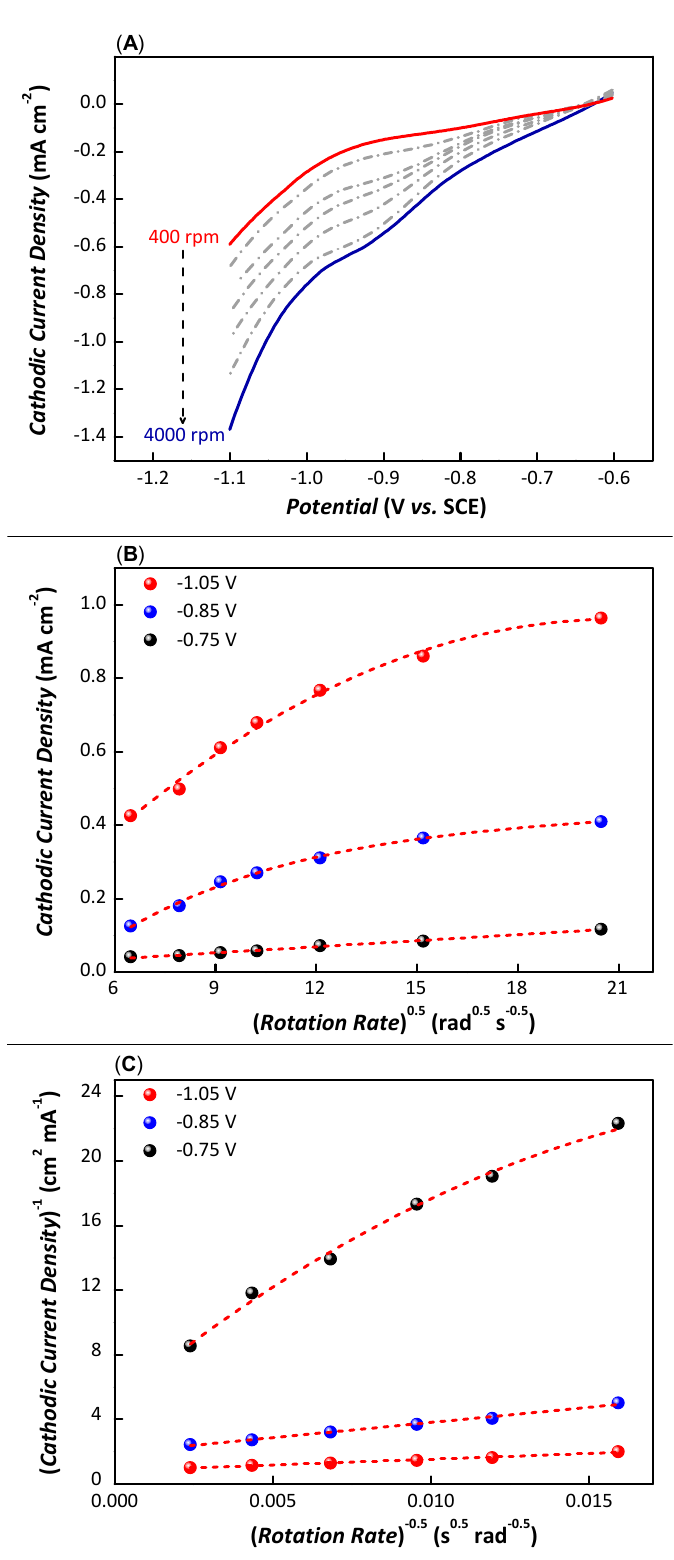
Figure 6 . ( A ) RDE responses for the electroreduction of CO 2 in 0.50 mol L − 1 KCl on the metallopolymer-modified electrode. The rotation rate was varied from 400 to 4000 rpm and the scan rate was 10 mV s − 1 . ( B ) Levich plot at potentials − 0.75, − 0.85, and − 1.05 V vs. SCE. ( C ) Koutecky–Levich plot at potentials of − 0.75, − 0.85, and − 1.05 V vs. SCE.